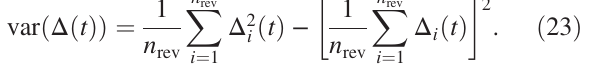
Figs. 6(a),(c) correspond to the (cid:3) 2 . 7 × 10 6 statistical error of measurement of var ð N Þ by our technique. Further, Fig. 6(c) has a curve for M , simulated by Eq. (2) (red line), and, for comparison, a curve for M , simulated by [[5] Eq. (49)] (dashed black line), which neglects beam divergence. Corresponding curves for simulated var ð N Þ are shown in Fig. 6(a). The shaded light red areas in Figs. 6(a),(c) show the uncertainty range of our simulation by Eq. (2).